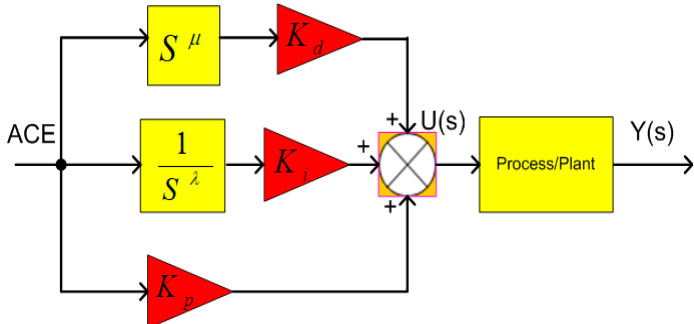
Figure 5. Design of FOPID controller. Fractal Fract. 2023 , 7 , x FOR PEER REVIEW